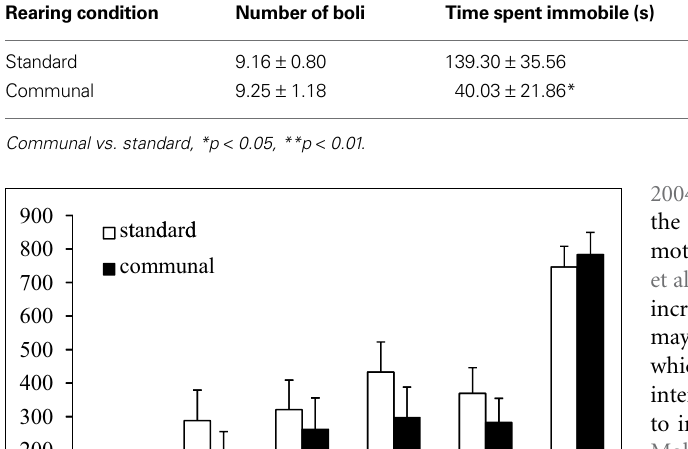
Table 4 | Open-fi eld behavior of F2 standard vs. communal female offspring. Rearing condition